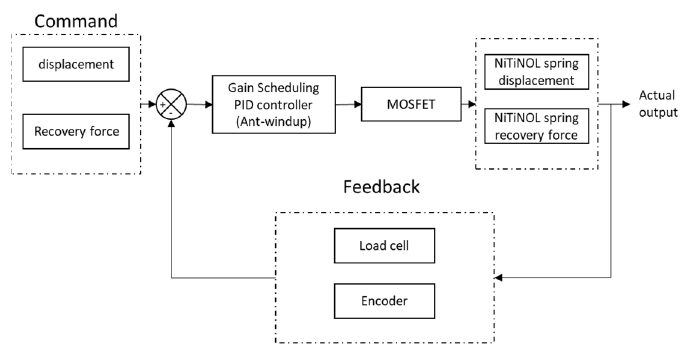
Figure 7. Functional block diagram for the force assessment system.